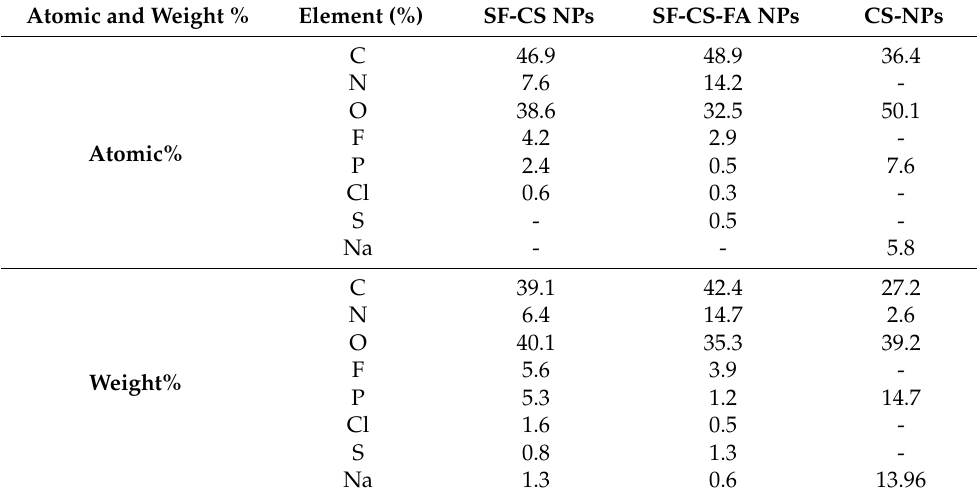
Table 4. Elemental compositions; atomic% and weight% of the nanoparticles obtained by the EDX